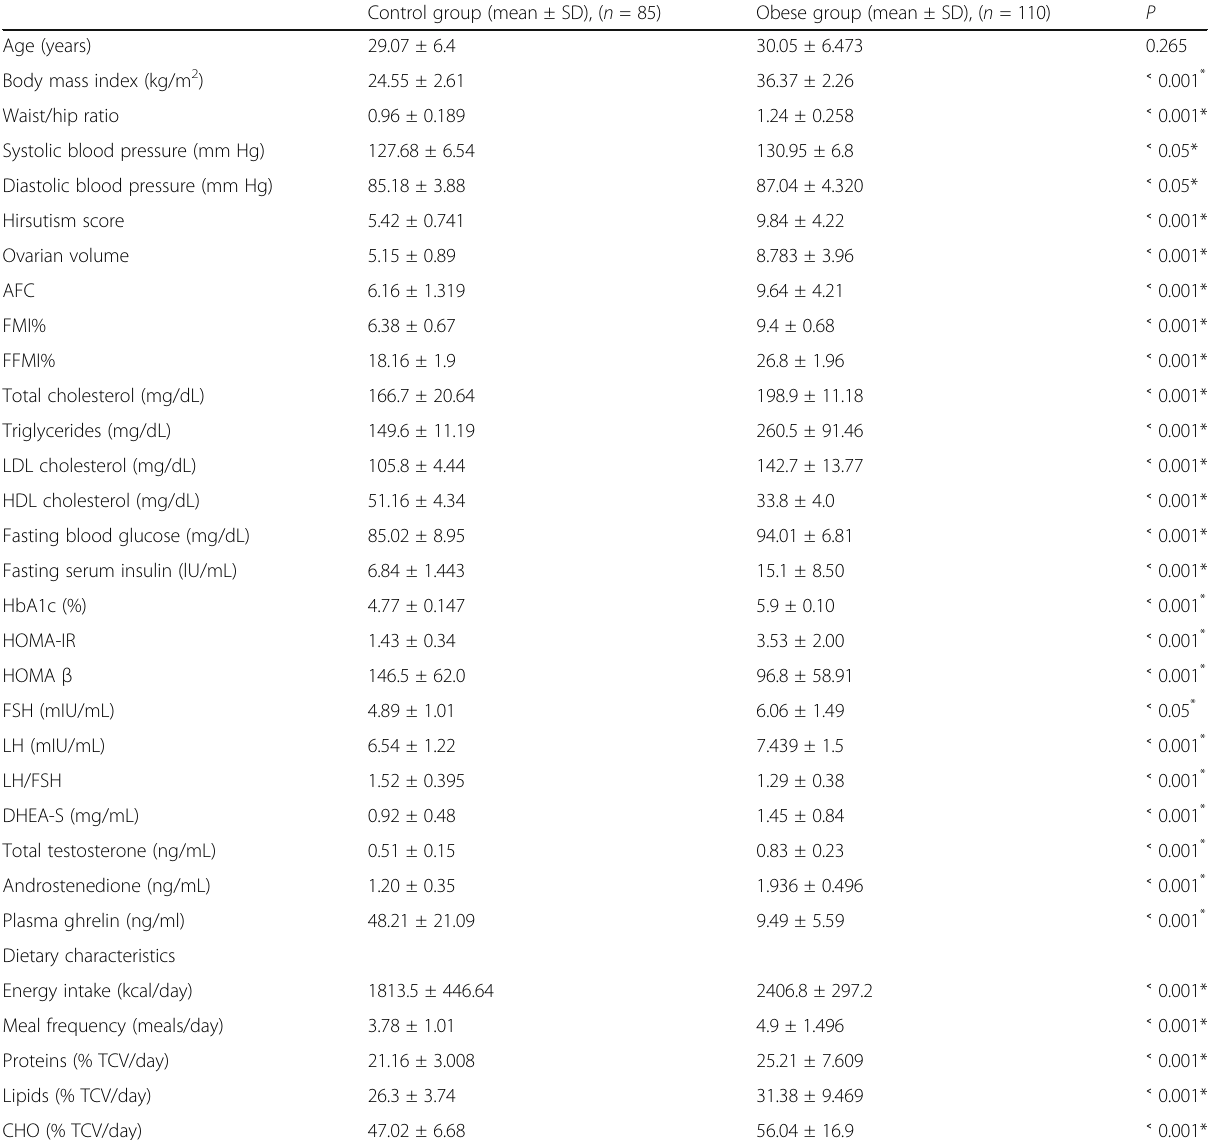
Table 1 Clinical, anthropometric, and laboratory characteristics at base line Control group (mean ± SD), ( n = 85) Obese group (mean ± SD), ( n =